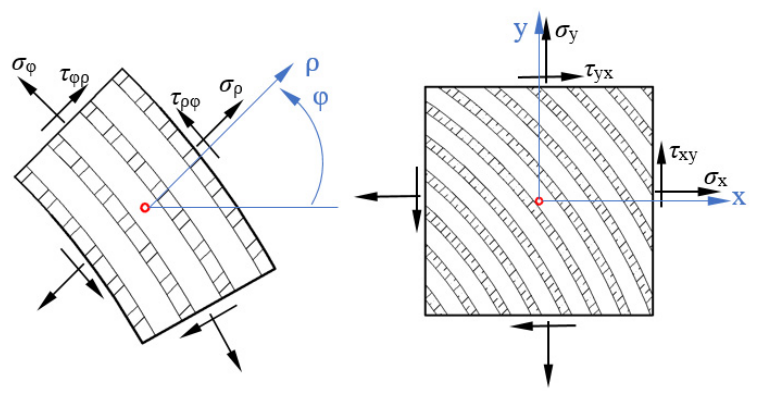
Figure 6. The stresses in polar coordinate ( left ) and Cartesian coordinate system ( right ). The stress–strain relationship for wood in the polar coordinate system is given by Equation (3) [17].